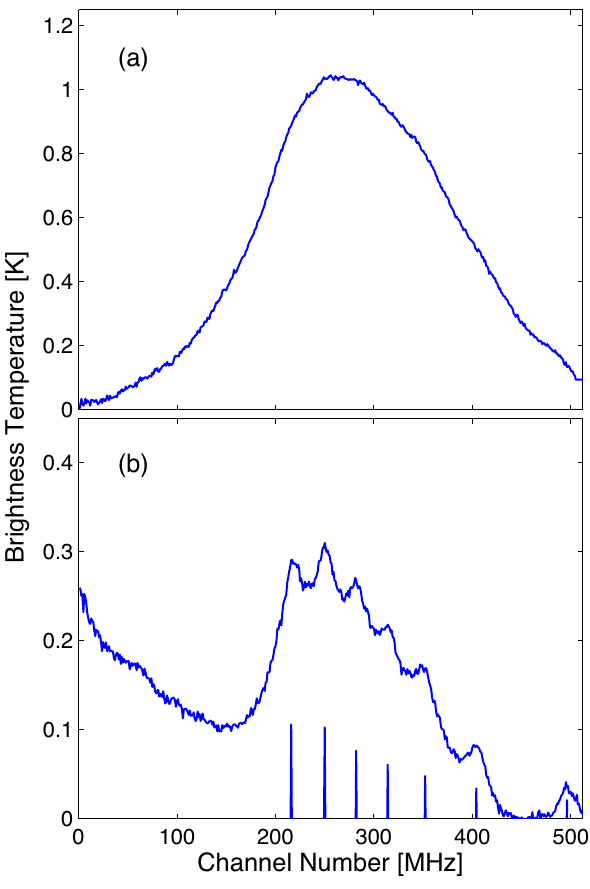
Fig. 1. Representative HNO 3 spectra recorded by the GBMS at South Pole in 1993 during polar fall (15 April) (a) and winter (3 August) (b) . See text for explanation of the different appearance of these examples. Individual HNO 3 line positions and relative inten- sities are indicated along the